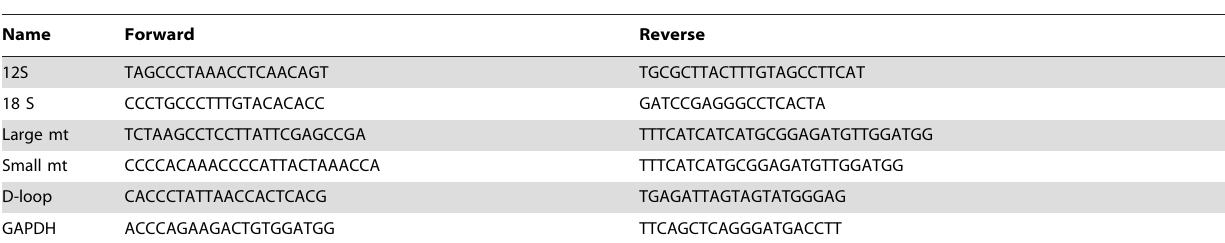
Table 1. Primer sequence used for